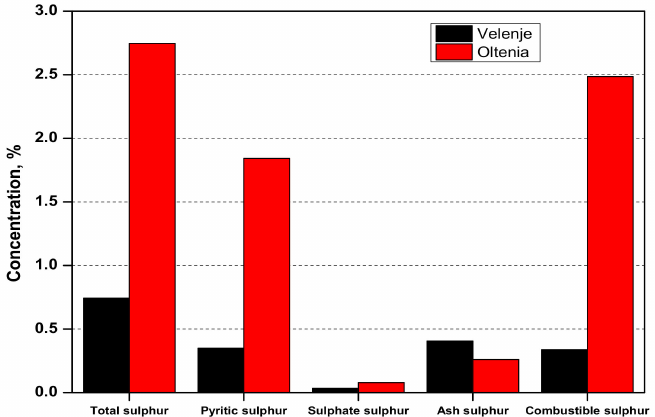
Figure 3. Sulfur forms in lignites used for ex situ gasification tests (dry